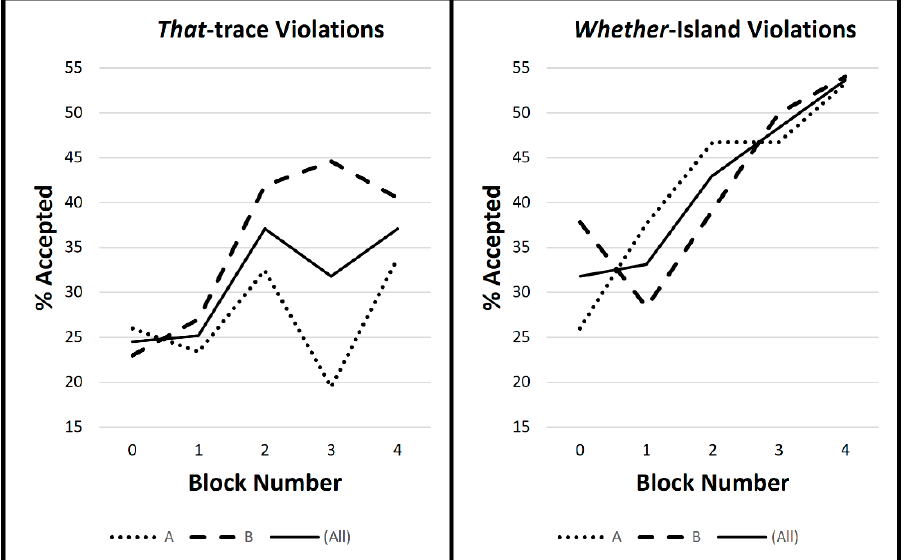
Figure 8. Comparison of That -trace and Whether -Island violations in Experiment III.